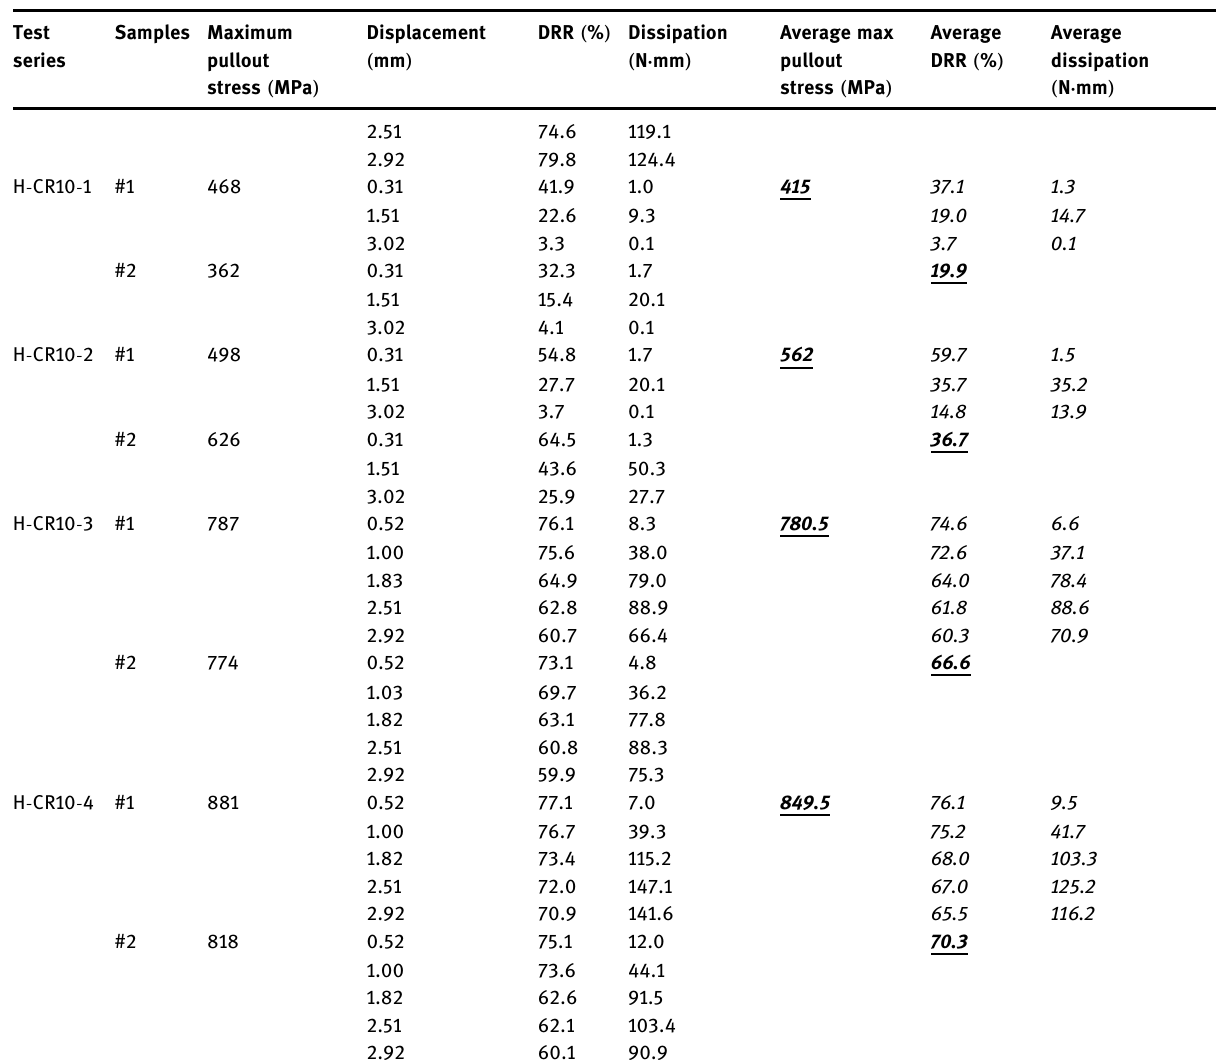
Figure 7. For the N - CR07 fi bers, the maximum pullout stress increased from CR1 to CR4 fi bers due to the increase of the wave depth, which ranged from 0.055 to 0.124 mm. in diameter and reduced the wave depth, as shown in Table 1. The increasing diameter was signi fi cant for shallow crimped fi bers, while the decreasing wave depth was dramatic for deep crimped fi bers. The diameter increased from 0.006 to 0.003 mm, and the wave